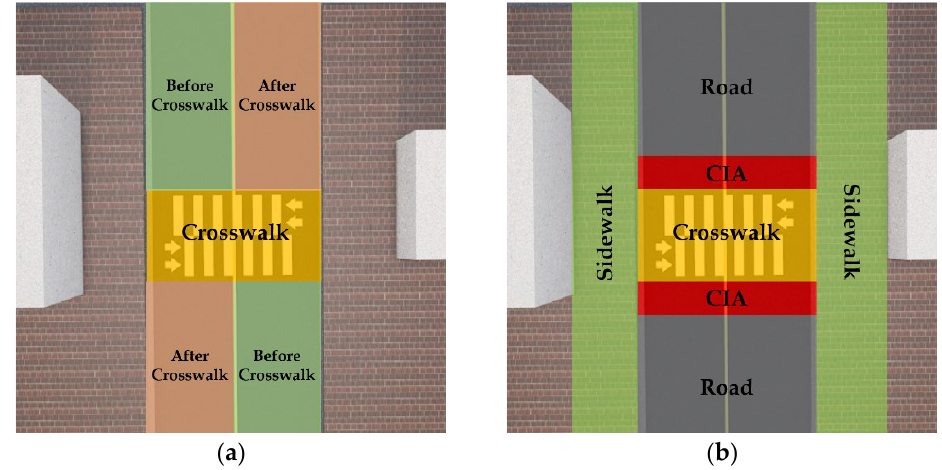
Figure 6. Categories of positions for: ( a ) vehicle, and ( b ) pedestrian.